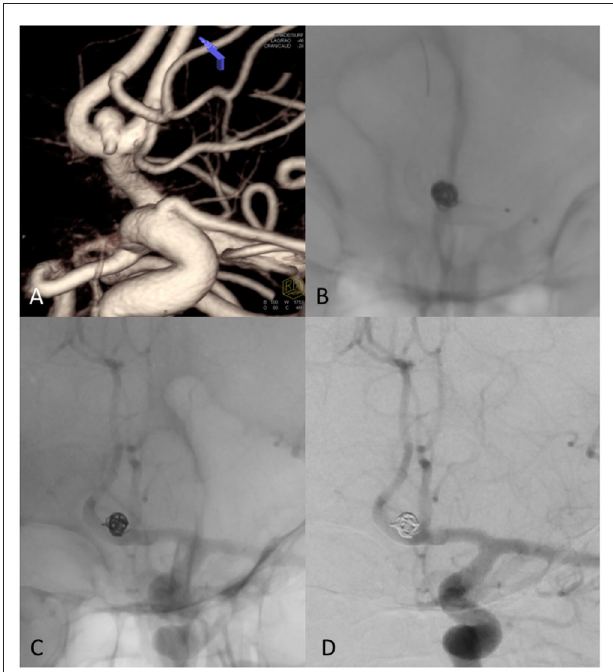
FIGURE 5 | (A) 3D Rotational angiography with volume rendering (VR) of ACom complex aneurysm that involving the anterior vessel wall with superior (larger) and inferior (very small, less than an 1mm) bleb. (B) Fluoroscopy shows coils and FD treatment (stent diameter: 2.75mm, length: 15mm) of the aneurysm sac. (C) Un-subtracted image where it is possible to see the stent and the flow of contrast with the coils of the same patient at 6 months showing complete exclusion of the sac, no contrast filling through the coils and regular patency of treated arteries. (D) DSA shows complete occlusion of aneurysm sac at 6-month